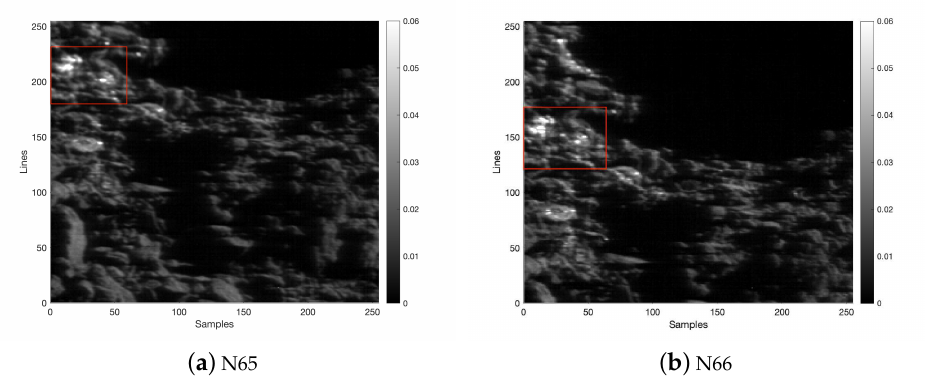
Figure 11. Radiance images of the lunar surface observed by the Yutu-2 rover at 750 nm. The images are stretched from 0 to 0.06 to illustrate the albedo variation. The image IDs are N65 and N66. The area marked by the red rectangle is the same lunar soil area considered for image